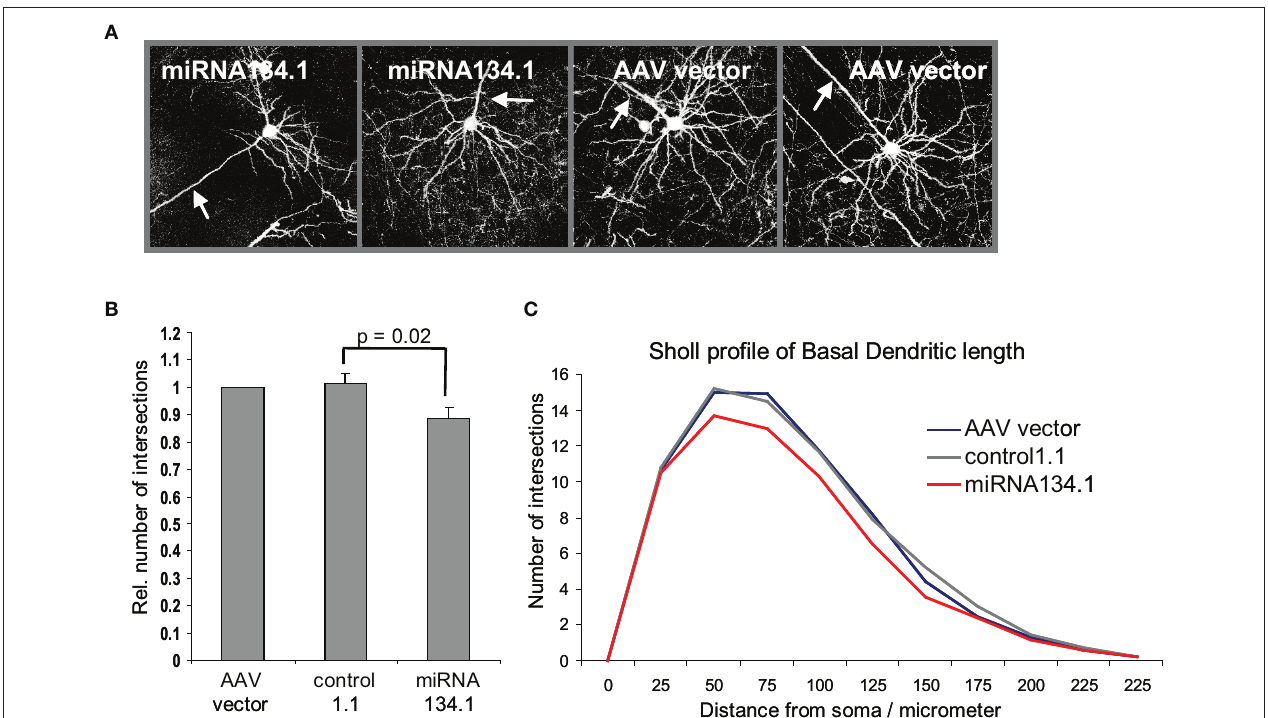
normalized to the number of intersections of neurons infected with AAV vector, which is arbitrarily set to 1. Results are shown as means + s.d. ( n = 3 independent experiments; at least six neurons each from two to three different brains per experiment; (a) AAV vector: 9 brains, 69 neurons, (b) control1.1: 8 brains, 61 neurons, (c) miRNA134.1: 8 brains, 57 neurons.). Indicated p-value was calculated using Student’s t -test. (C) Sholl profi le of the basal dendritic length of cortical layer V pyramidal neurons. The number of dendritic intersections with each concentric circles is plotted against the distance of the individual circles from soma, 25 µm interval (Between-Subjects ANOVA: p = 0.002 and 0.013 comparing the miRNA134.1 condition to the control1.1 and AAV condition,